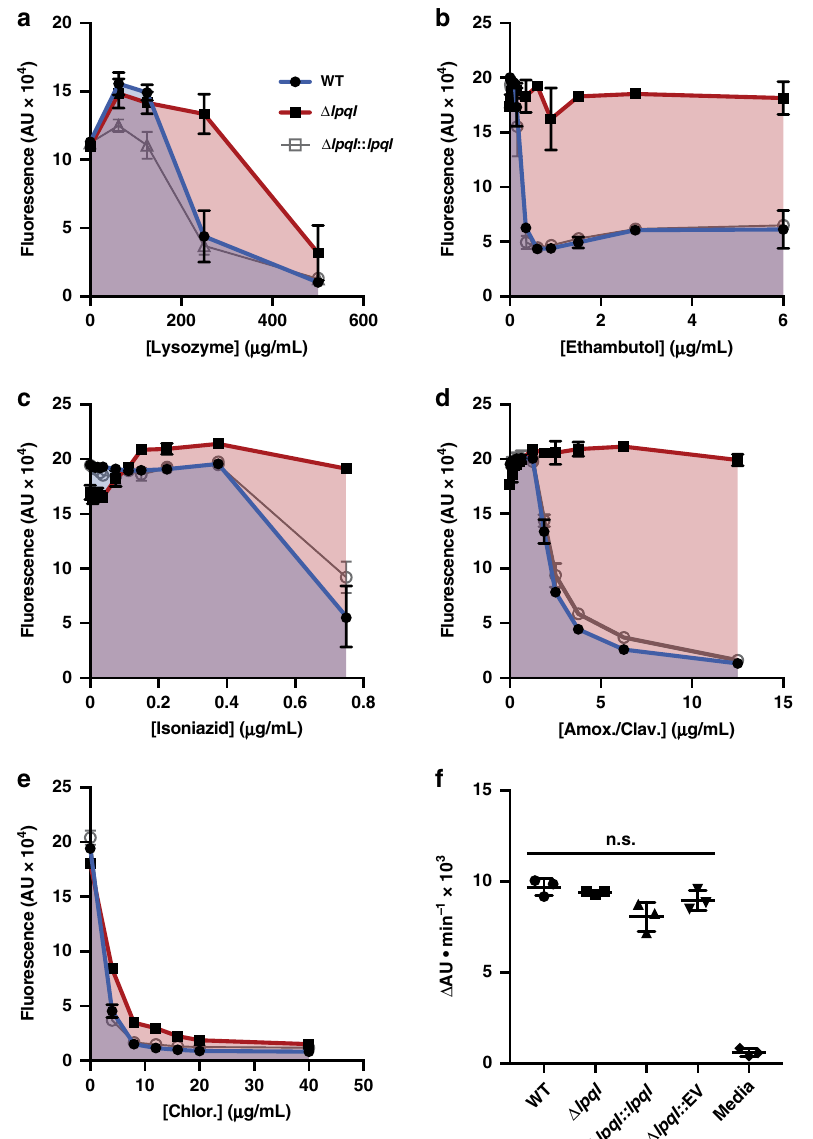
Fig. 5 Loss of LpqI leads to lysozyme and antibiotic resistance. a – e M. bovis BCG WT (blue), Δ lpqI (red), and Δ lpqI :: lpqI (grey) were incubated with increasing concentrations of lysozyme or antibiotics at a starting OD 600 of 0.1. After 7 days incubation total growth was assessed using a resazurin assay, where total fl uorescence correlates with respiration and growth ( n = 3; error bars are ± SD; Amox./Clav — amoxicillin plus clavulanic acid; Chlor. — chloramphenicol). f M. bovis BCG WT, Δ lpqI and Δ lpqI :: lpqI and Δ lpqI ::EV were incubated with EtBr and the rate of EtBr uptake was monitored as